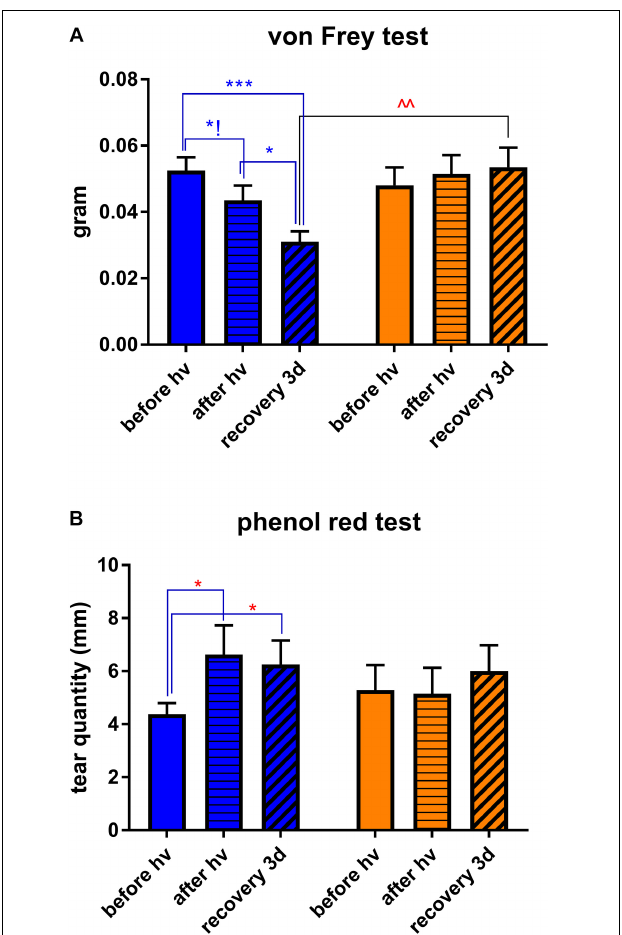
FIGURE 2 | Clinical assessments. Measurements were made at three time points: before h ν , before the beginning of illumination; after h ν , directly after 3 h of illumination; recovery 3d , after 3 days of recovery in standard illumination conditions of animal unit. (A) Measurement of corneal mechanical sensitivity performed by means of von Frey hair test. Greater values mean lower corneal sensitivity. Statistical significance: blue illumination group: before h ν vs. after h ν – q = 0.0361, p = 0.1031; before h ν vs. recovery 3d – q = 0.0003, p = 0.003; after h ν vs. recovery 3d – q = 0.0136, p = 0.0260; recovery 3d group: blue vs. yellow – q = 0.0041, p = 0.0020. (B) Measurement of tear quantity performed by means of phenol red thread test placed into the eye for 30 s. Greater distances mean more important lacrimation. Statistical significance for the blue illumination group: before h ν vs. after h ν – q = 0.0403, p = 0.0192; before h ν vs. recovery 3d – q = 0.0498, p = 0.0475. Blue and yellow bars correspond to blue and yellow exposures, respectively. All the data are presented as mean ± SEM. Differences were considered significant when p < 0.05 ( ∗ / ∧ ), p < 0.01 ( ∗∗ / ∧∧ ), p < 0.001 ( ∗∗∗ / ∧∧∧ ) or p < 0.0001 ( ∗∗∗∗ / ∧∧∧∧ ). Stars correspond to comparisons between values at different time points, within one spectrum. Carets correspond to comparison between blue-illuminated and yellow-illuminated mice, at the same time point. Red color means increase and blue color decrease in values.